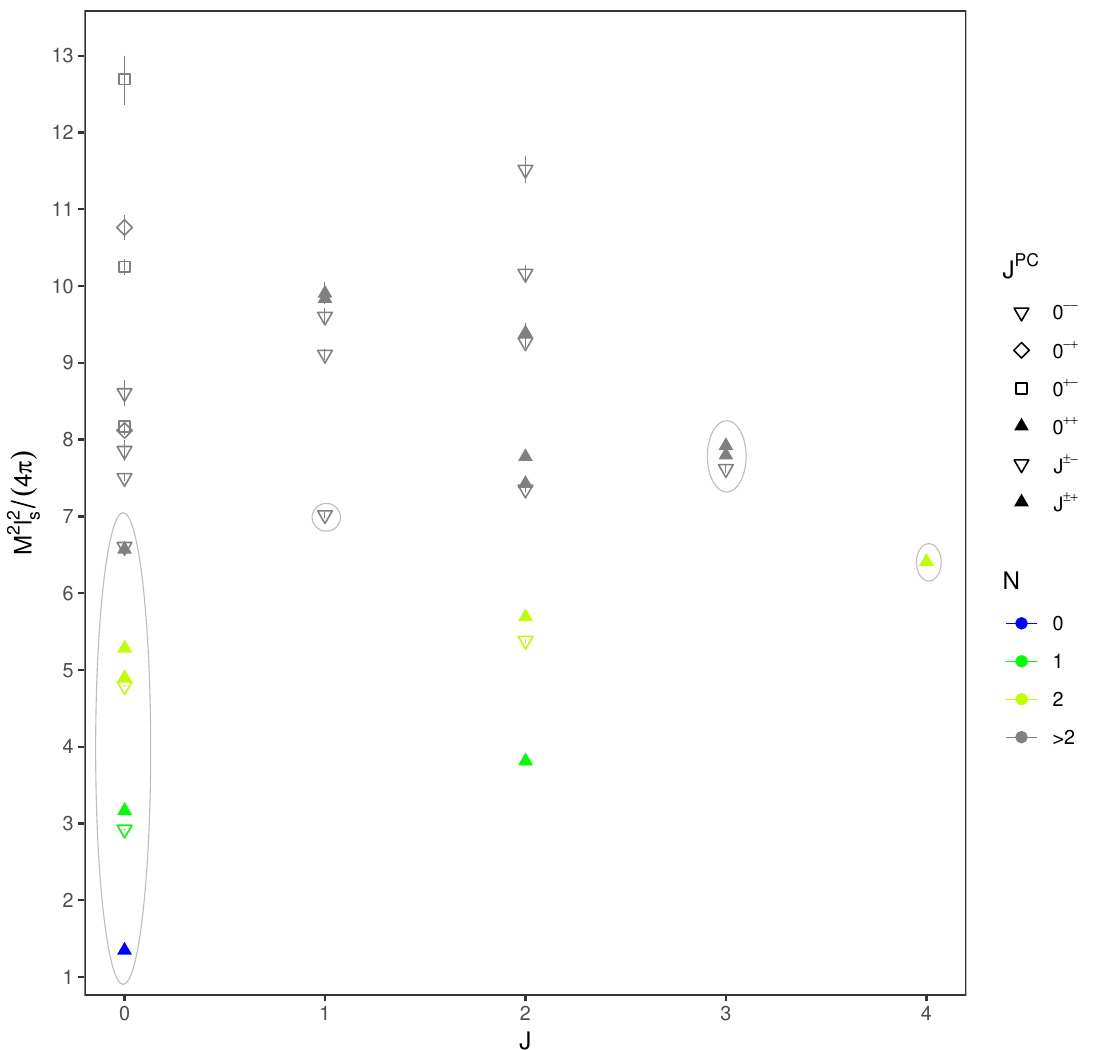
Figure 1. Glueball spins determinations prior to this work; masses are SU( 1 ) limits or in a few cases SU(16) or SU(12) masses from [22]. States circled had spin determined in [18] or for J = 0 states by lack of a candidate partner of opposite parity (see also [17]). The string width l s is the inverse of the square root of the string tension (cid:27) f .